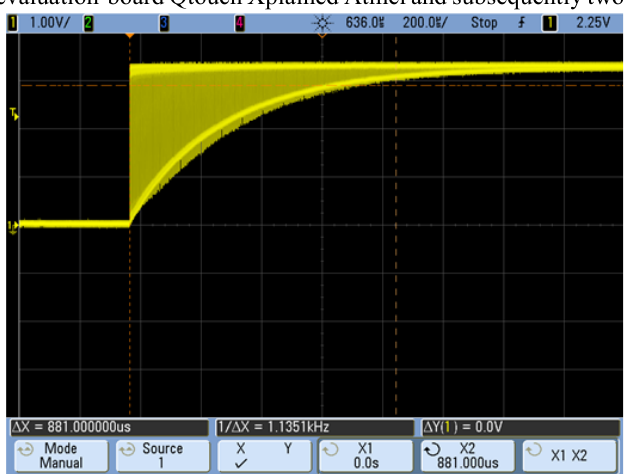
Fig. 6. Charge transfer cycle of 0,881 ms for the touch case, where is assumed for Cx=5-10 pF and Cs=12nF.